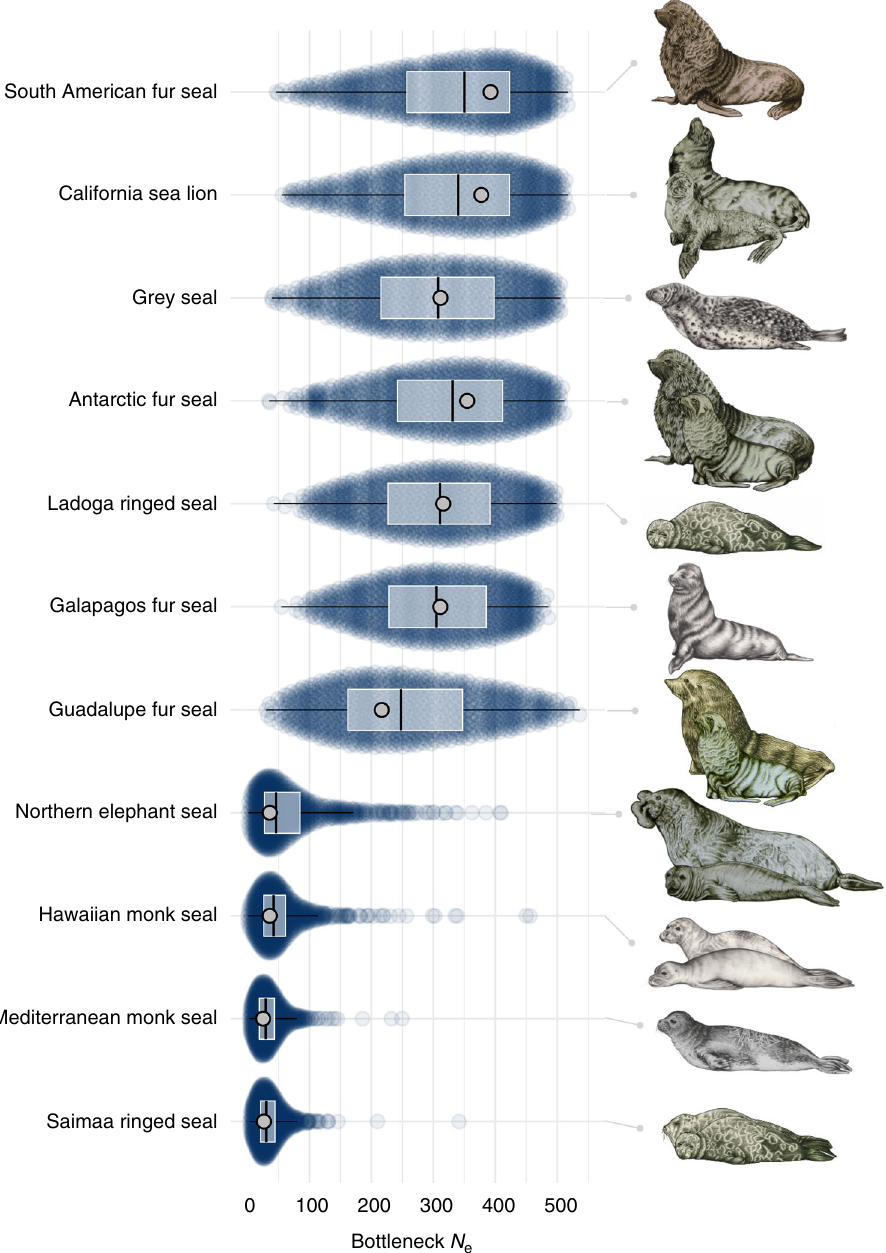
Fig. 2 Estimated bottleneck effective population sizes. Posterior distributions of N e bot are shown for 11 species for which the bottleneck model was supported in the ABC analysis, ranked according to the modes of their density distributions which re fl ect the estimated most likely N e bot. Prior distributions are not shown as N e bot was drawn from a uniform distribution with U[1, 500]. For each species, parameter values for 5000 accepted simulations are presented as a sinaplot, which arranges the data points to re fl ect the estimated posterior distribution. Superimposed are boxplots (centre line = median, bounds of box = 25th and 75th percentiles, upper and lower whiskers = largest and lowest value but no further than 1.5 * inter-quartile range from the hinge) with light grey points representing maximum densities. The pinniped art in this fi gure was created by Rebecca Carter (www. rebeccacarterart.co.uk) and is reproduced here with her permission. All rights